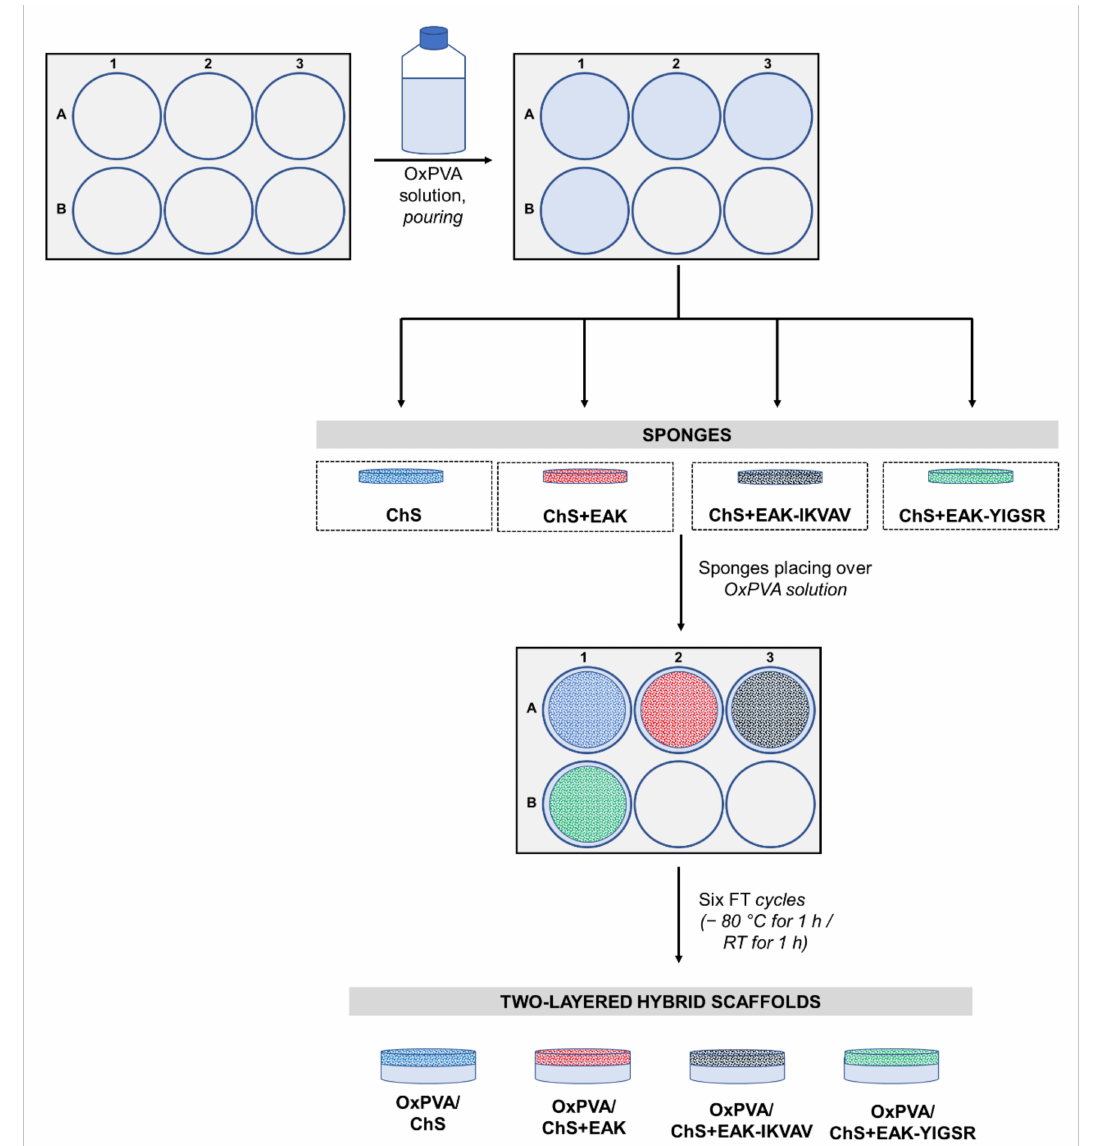
Figure 10. Fabrication of two-layered hybrid scaffolds based on oxidized polyvinyl alcohol (OxPVA) and bioactivated chitosan sponges. The OxPVA solution was poured into moulds; hence, the sponges comprising chitosan alone (ChS); chitosan functionalized with the self-assembling-peptide EAK (ChS+EAK); chitosan functionalized with the self-assembling-peptide EAK + the laminin-derived sequence -IKVAV (ChS+EAK-IKVAV); and chitosan functionalized with the self-assembling-peptide EAK + the laminin-derived sequence -YIGSR (ChS+EAK-YIGSR) were carefully positioned over the polymer solution. After exposing the system to six freezing thawing (FT) cycles (one cycle: − 80 ◦ C for 1 h followed by room temperature (RT) for 1 h), the two-layered hybrid scaffolds (OxPVA/ChS; OxPVA/ChS+EAK; OxPVA/ChS+EAK-IKVAV; OxPVA/ChS+EAK-YIGSR) were